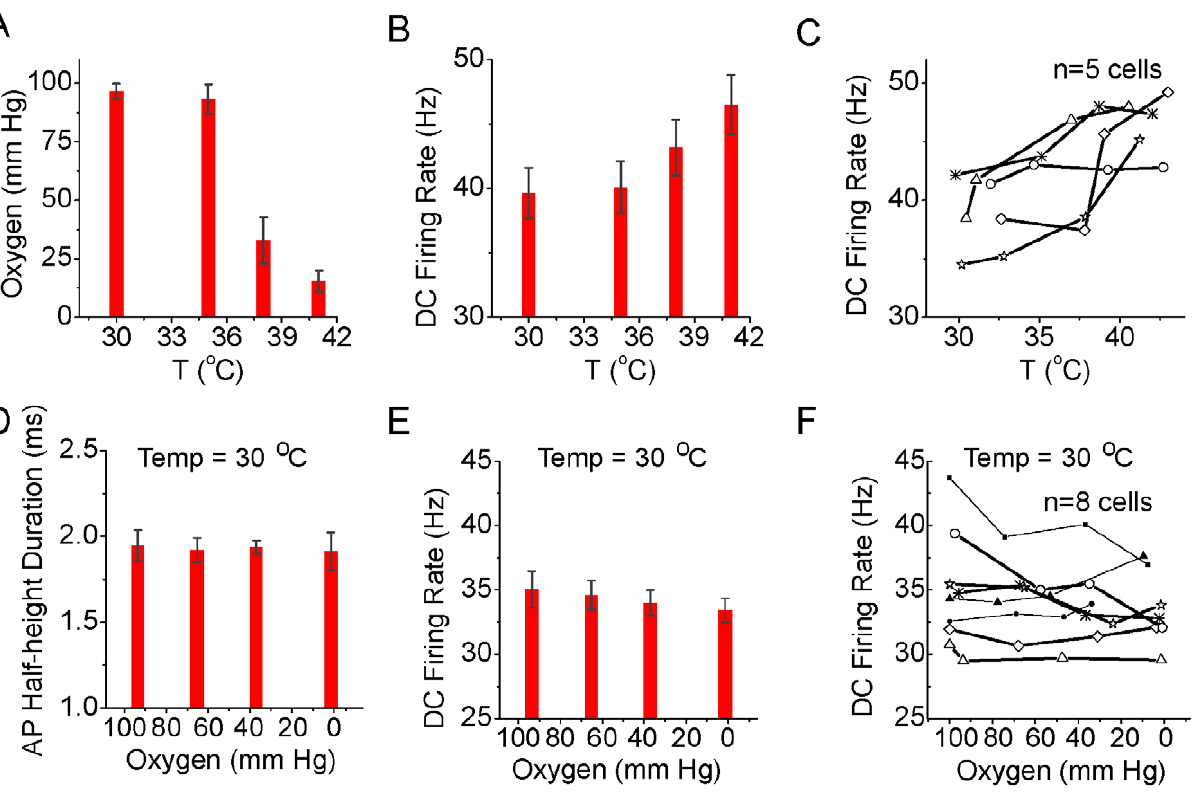
Figure 10. Increasing temperature decreases oxygen concentration and decreasing oxygen content decreases neuronal excitability. A. Oxygen levels (mm Hg), as measured at the upper surface of the slice, at different temperatures. Increasing temperature can dramatically decrease oxygen levels. B. Response of layer 2/3 pyramidal cells (n=5) to the intracellular injection of a depolarizing current pulse (200 pA, 500 ms) at different temperatures (same experiments as in A). C. Plot of response of individual cells to the current pulse at different temperatures. D–F. Decreasing oxygen levels (mm Hg) at a constant temperature of 30 u C does not have a significant effect on the duration of action potentials (D), but does decrease average firing rate (E), as seen in individual recordings (F; n=8